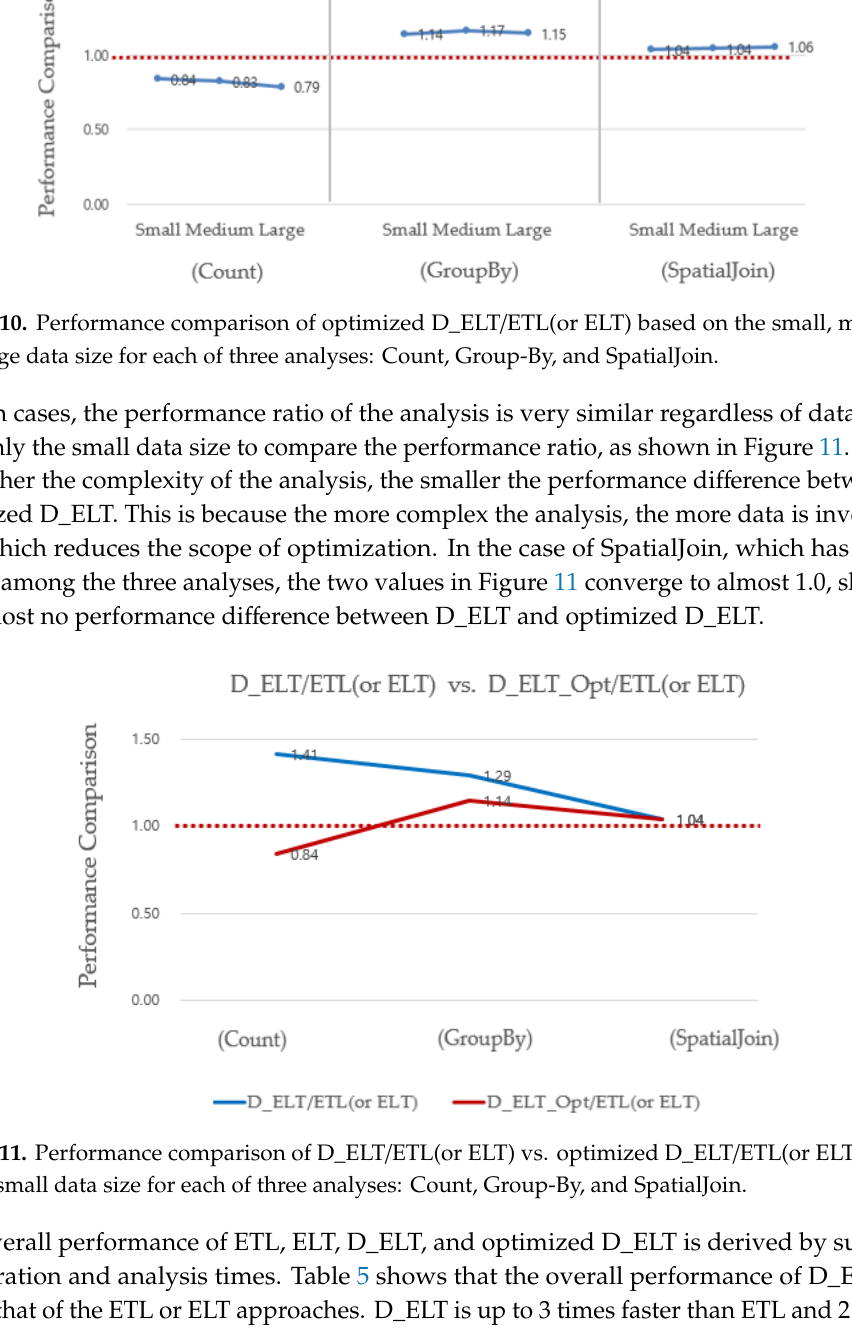
Figure 11. Performance comparison of D_ELT/ETL(or ELT) vs. optimized D_ELT/ETL(or ELT) based on the small data size for each of three analyses: Count, Group-By, and SpatialJoin.